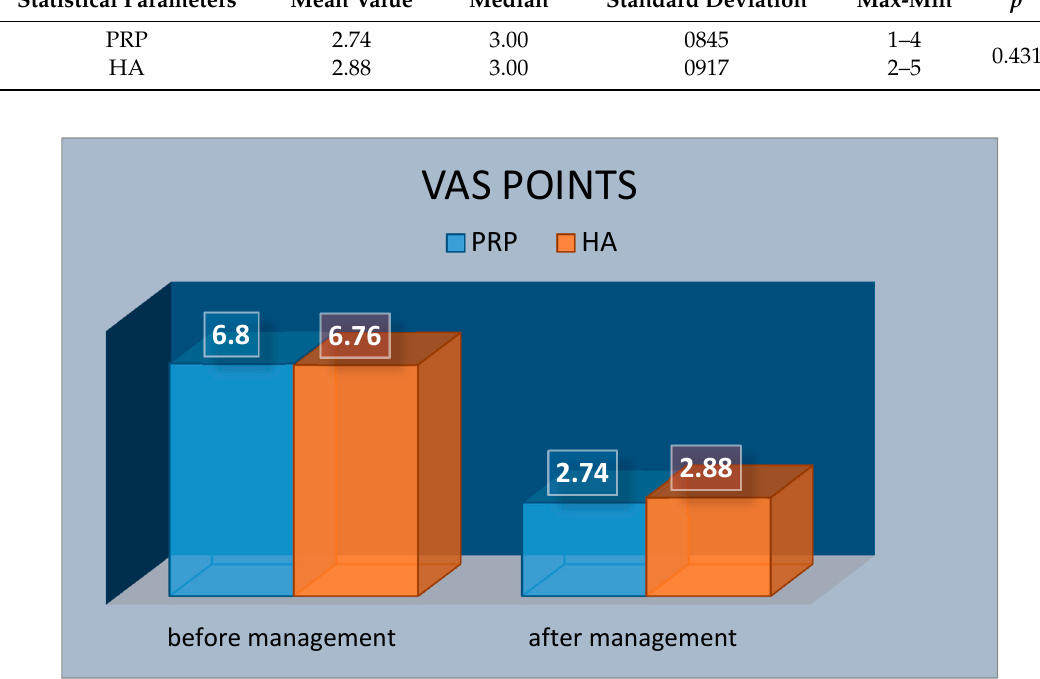
Figure 4. Mean value of Visual Analogue Score (VAS) points—of the temporomandibular joint’s pain before and after management in platelet rich plasma (PRP) and hyaluronic acid (HA) groups.